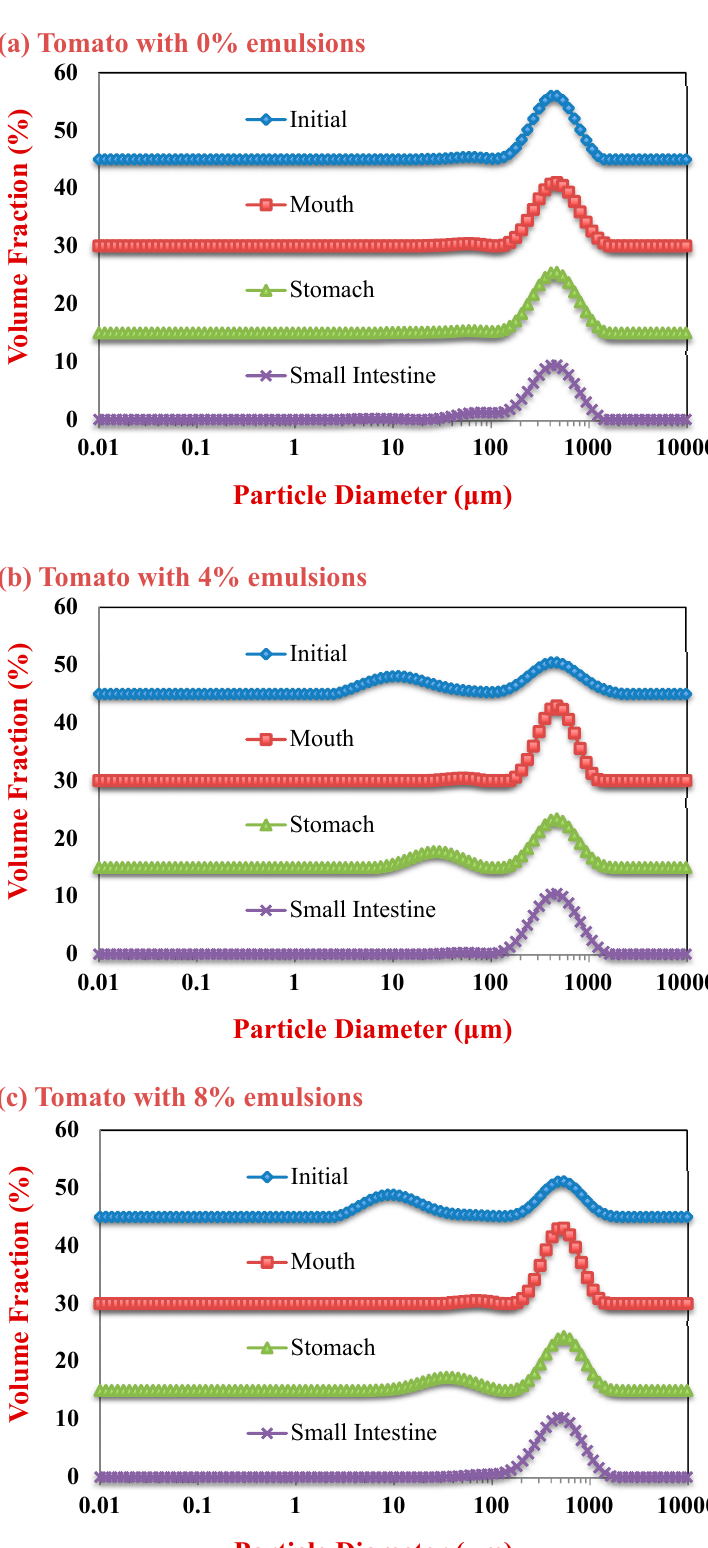
Figure 3. Microstructure of samples with different lipid contents after they were incubated under different GIT conditions. In the absence of emulsion (0% oil), the initial tomato samples had a fairly high negative charge (–31 mV) (Figure 4), which may have been due to anionic colloidal particles or biopolymers, such as plant-cell fragments or pectin. The magnitude of the negative charge was considerably lower in the mixed systems (–21.1 and − 14.5 mV) than in the emulsions alone (–66 mV). This phenomenon may be the result of charged substances associated with the tomato tissues, such as plant cell fragments, organic acids, mineral ions, or biopolymers [29,30]. These substances may have contributed to the electrophoresis signal used to determine the ζ -potential of the mixed samples. Alternatively, they may have absorbed to the surfaces of the lipid droplets or increased the ionic strength of the surrounding solution [25], thereby reducing the magnitude of the ζ -potential.